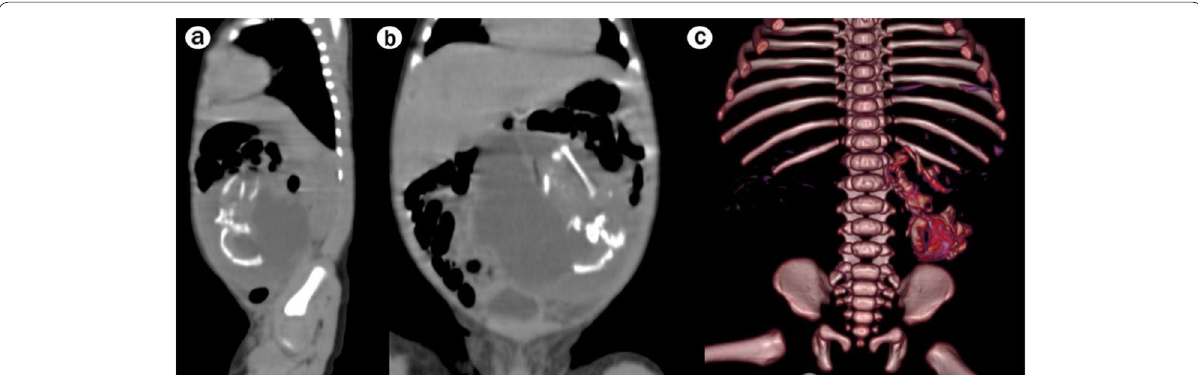
Fig. 3 Multislice CT of the abdomen and pelvis of the newborn baby after delivery. a , b Showing the ossified bony parts within the fetal abdomen. c A 3D reconstruction image of the suspected mass